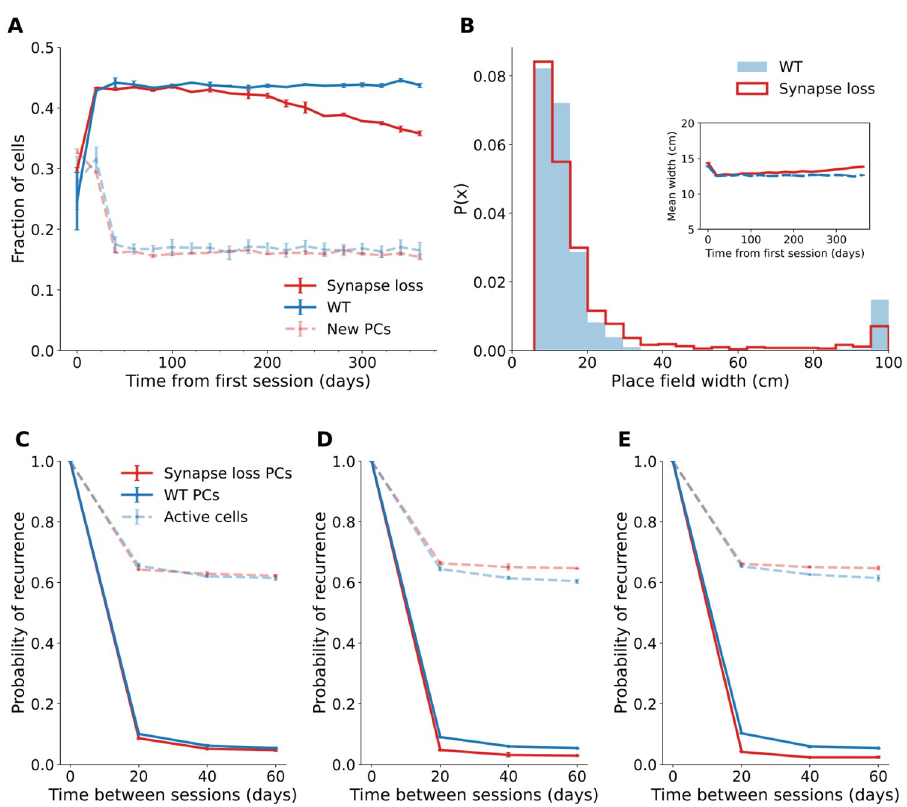
Fig 7. Place cell properties diverge from the wildtype in the double synapse loss model. (A) Proportion of total (dark lines) and new (pale lines) place cells over 365 days in the double synapse loss and wildtype (WT) model. Error bars show standard deviation across two runs of the simulation. (B) Representative probability density function of place field widths on day 360. Inset: Mean field width over 365 days, excluding widths > 50 cm. Error bars show pooled standard error of all place fields across two runs of the simulation. (C-E) Probability of recurrence for active cells and place cells across sessions 20 to 60 days apart from day 20 (C), day 200 (D) and day 300 (E). Error bars show standard deviation across two runs of the